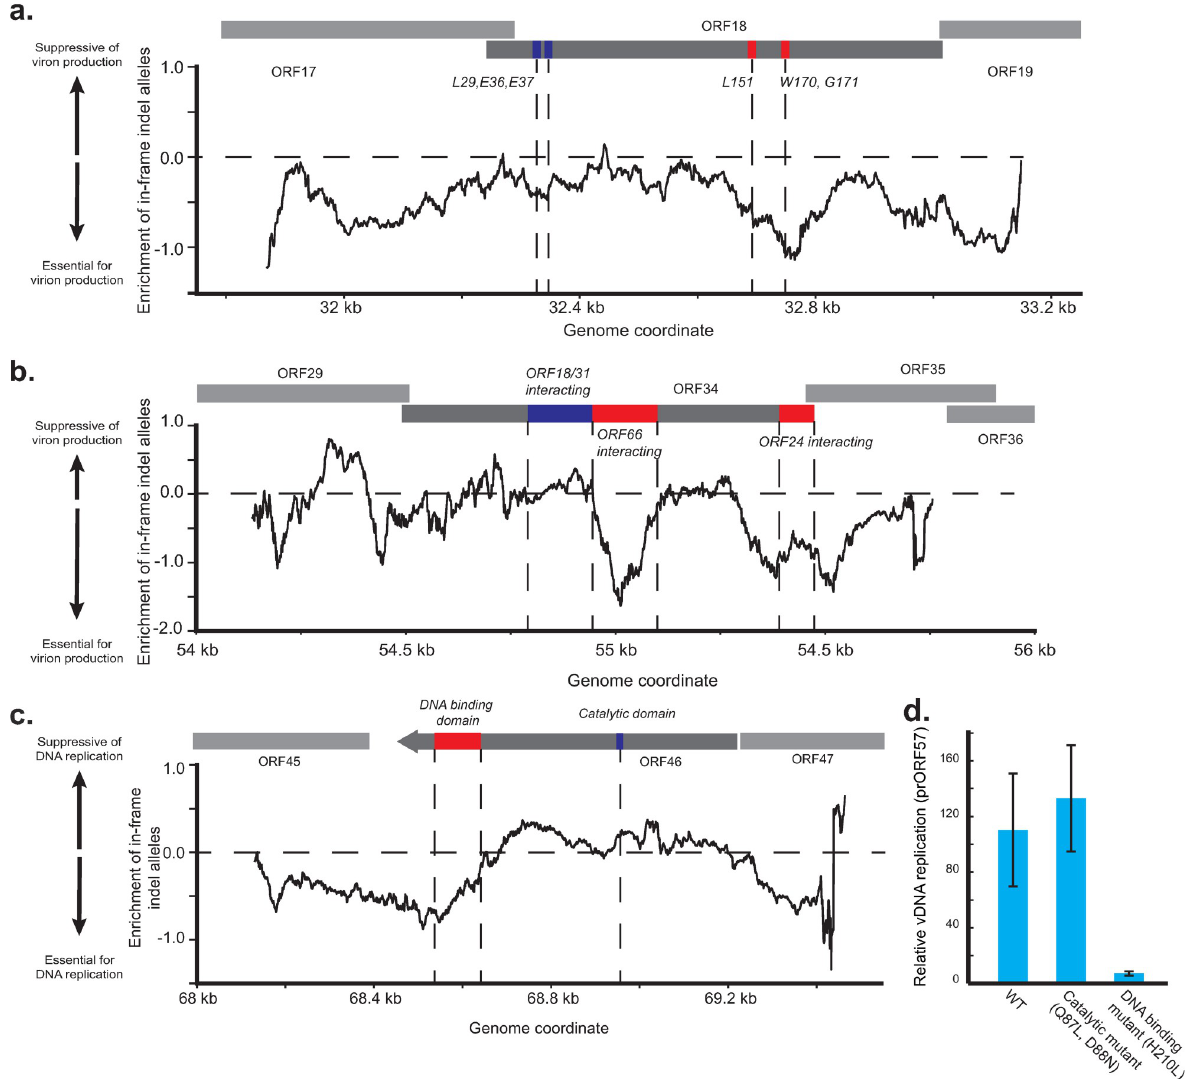
Fig 4. Targeted deep sequencing reveals essential domains of ORF46. a,b) Smoothed signal from in-frame mutations across the a) ORF18 and b) ORF34 loci in comparison between replicating and supernatant genomes. Functional domain labeling for ORF18 [39] and ORF34 [40]. c) Smoothed signal from in-frame mutations across the ORF46 loci in comparison between latent and replicating genomes. In-frame mutations were defined as insertions or deletions whose size where divisible by three. The number of mutations was pooled in a 100 bp window and enrichment was calculated relative to the enrichment of out-of-frame mutations. A negative value indicates that in-frame mutations were relatively depleted at the indicated region. Previously described domains and residues are indicated in red if they appear depleted and blue if they do not. d) vDNA replication was measured for iSLK cells infected with KSHV encoding either wildtype ORF46, a catalytic domain mutant of ORF46 (Q87L, D88N), or a DNA- binding domain mutant of ORF46 (H210L). Cells were reactivated, and after 48 hours DNA was extracted, and viral DNA quantity was measured by qPCR of the viral ORF57 promoter. Quantity is relative to unreactivated samples. Error bars are standard error from four independent